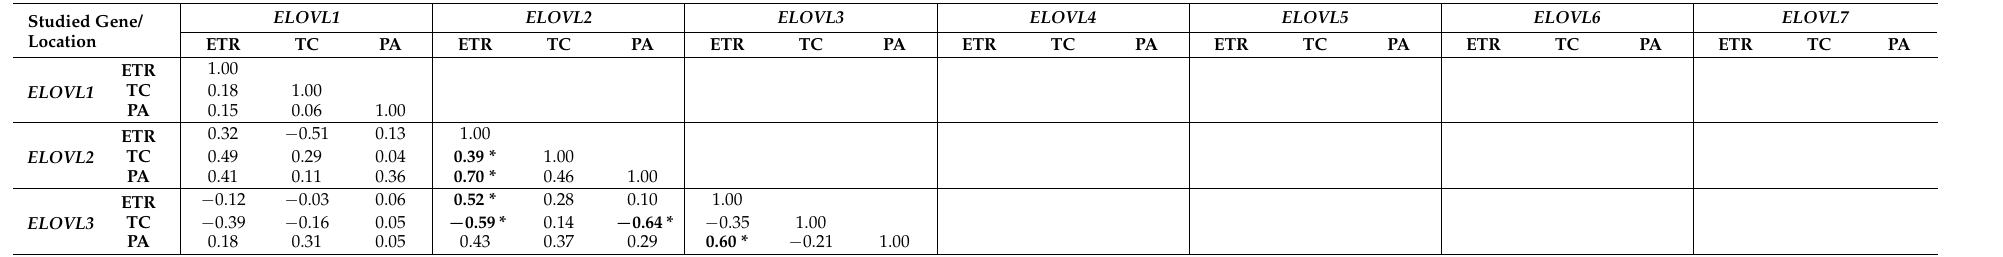
Table 3. Mutual correlations between the expression of the studied elongases, and correlations between the expression of the elongases and GBM tumor regions in